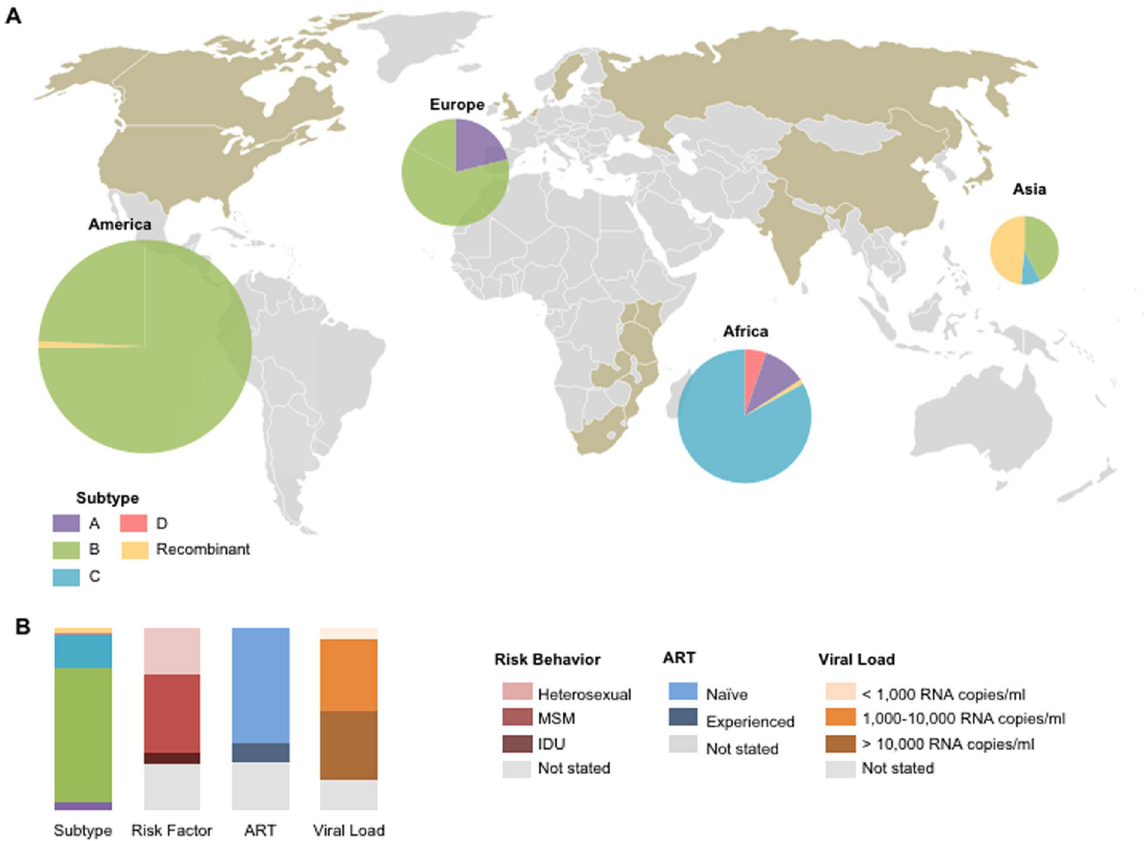
Figure 1. Global cohort characteristics ( A ). Geographic and subtype distribution of 805 specimens from the shaded (taupe) countries. These specimens are further described in Tables 1 and S1–S5. Pie charts indicate the subtype of included specimens, where the diameter denotes the proportional representation of each continent to the total specimen. The map was generated by Microsoft PowerPoint (Version 15.30) using a template available at https://commons.wikimedia.org/wiki/File:Color_world_map.png which is released into the public domain at Wikimedia Commons, free media repository. ( B ). The profiles of the 805 specimens’ subtype, risk behaviors, ART status, and viral